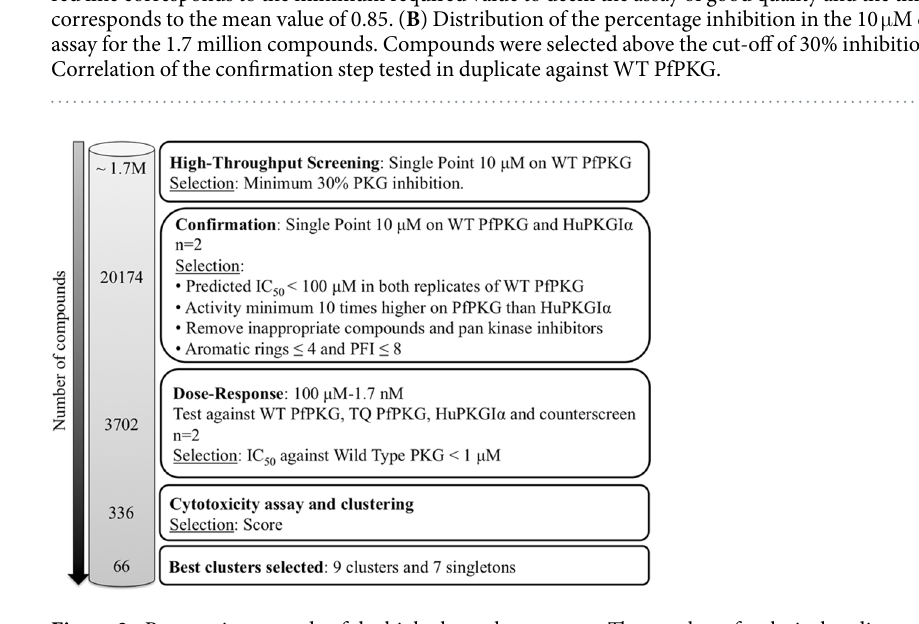
Figure 2. Progression cascade of the high-throughput screen. The number of technical replicate assays is indicated (n). Individual steps of the cascade are described in the